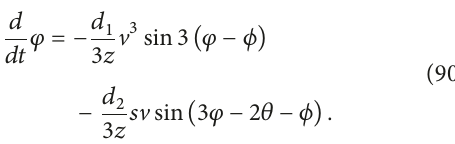
Figure 4: Dependence of 𝑎 󸀠 , 𝑏 󸀠 and 𝑏 . The solid and dashed curves represent 𝑎 󸀠 and 𝑏 𝑑 󸀠 𝑑 󸀠 1 and 2 ,